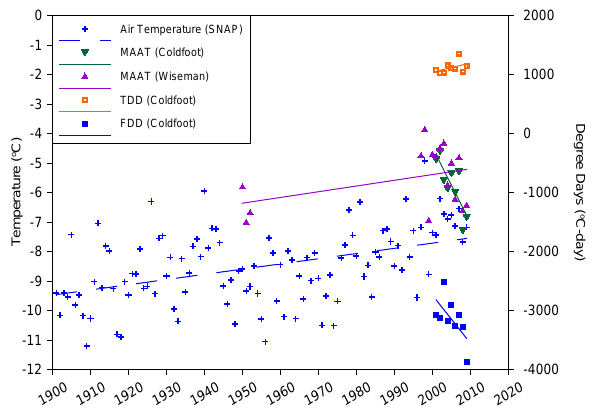
Figure 6. Mean annual air temperature near FDL-A.Reanalysis data is from SNAP; measured 2 Fig. 6. Mean annual air temperature near FDL-A. Reanalysis data is data was taken from the SNOTEL site near Coldfoot (60 km south of FDL-A) and near Wiseman 3 from SNAP; measured data was taken from the SNOTEL site near (50 km south of FDL-A) (National Water and Climate Center, part of the Natural Resources 4 Coldfoot (60km south of FDL-A) and near Wiseman (50km south Conservation service); thawing and freezing degree days are for Coldfoot. 5 of FDL-A) (National Water and Climate Center, part of the Natural Resources Conservation service); thawing and freezing degree days are for